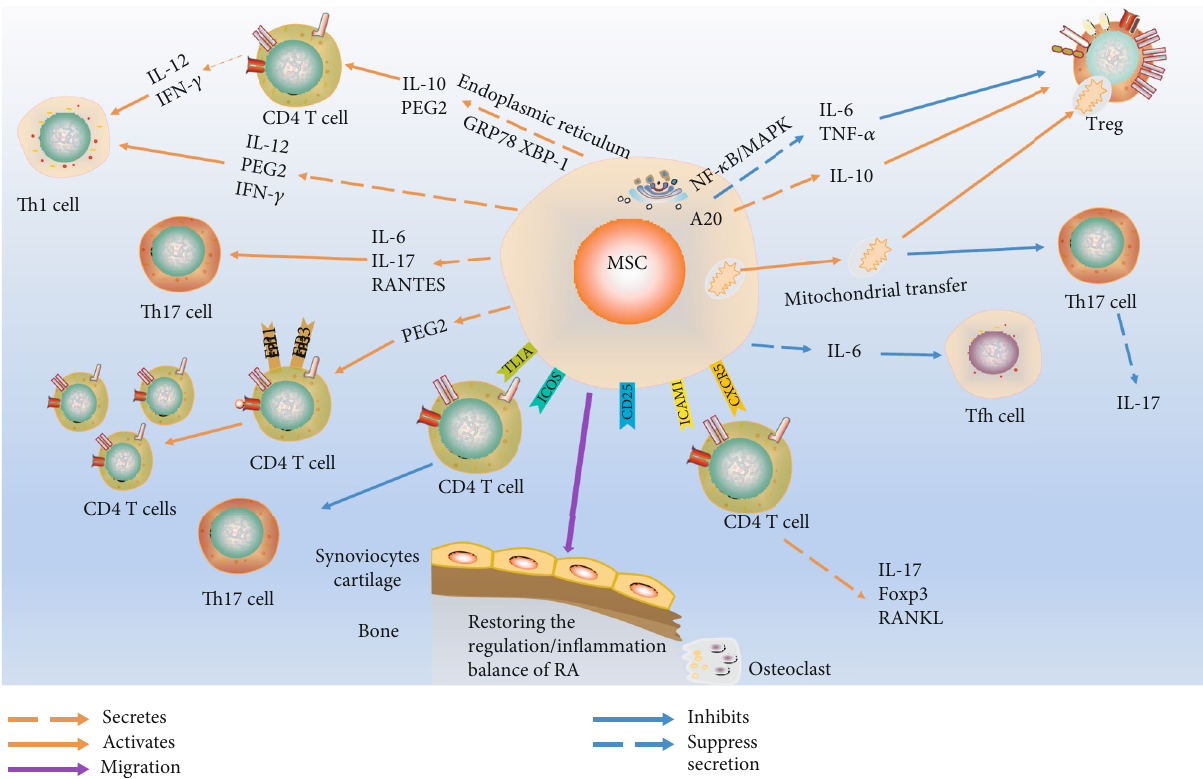
Figure 2: MSCs relieve RA by regulating T cells. MSCs can regulate the balance of T cells by homing to the articular cavity and secreting a series of cytokines that increase the anti-in fl ammatory activity of the environment. T cells are also regulated via the transfer of mitochondria from MSCs to T cells. Additionally, MSCs under endoplasmic reticulum stress can also play a regulatory role in inducing T